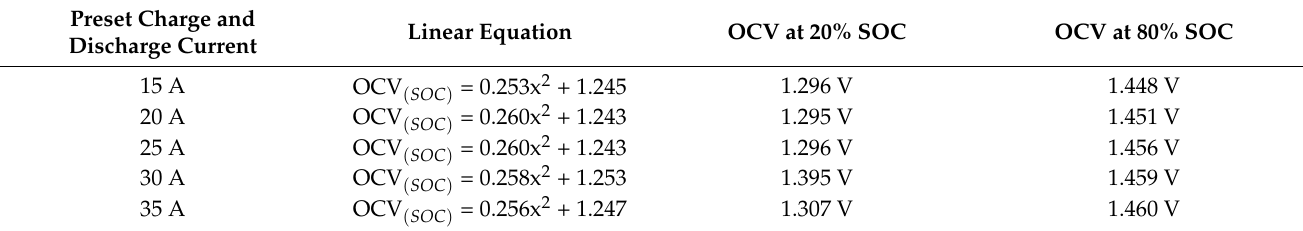
Table 3. Parameters after linear regression of the individual measurement